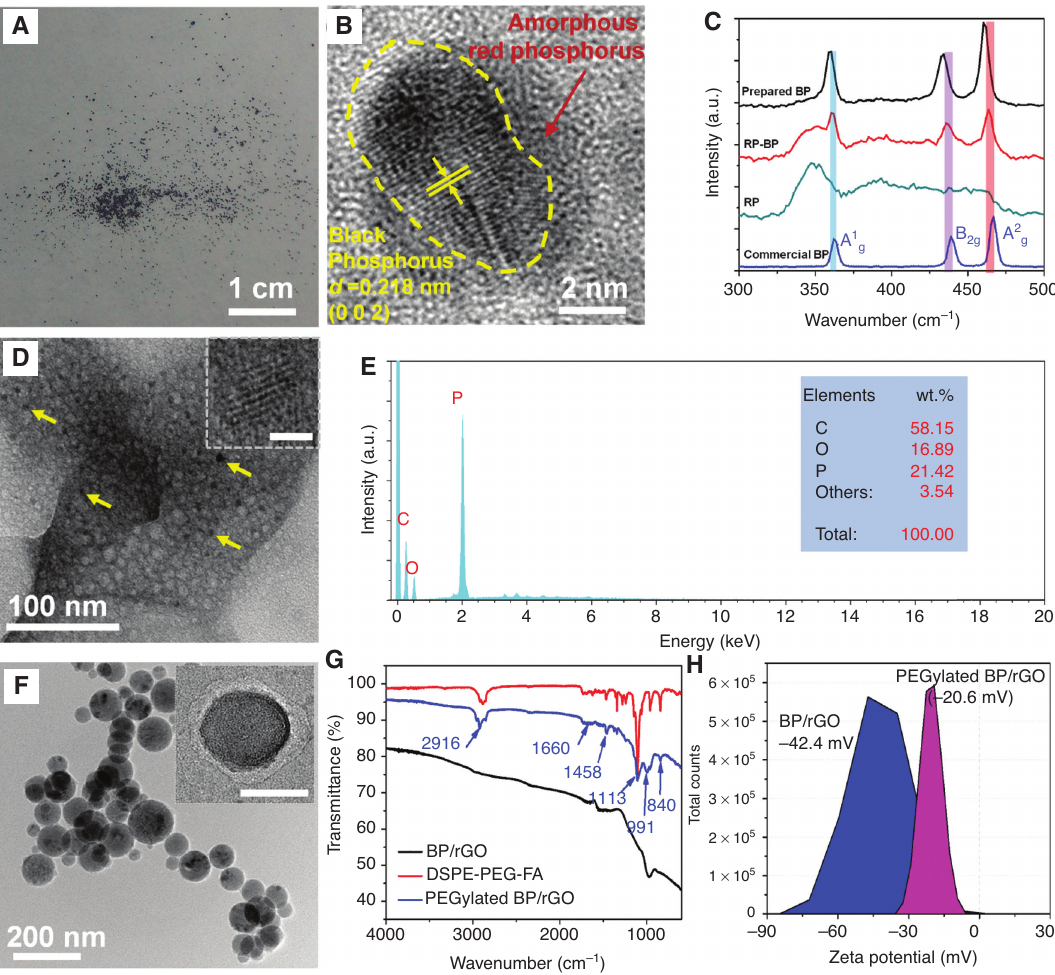
Figure 2: Synthesis and